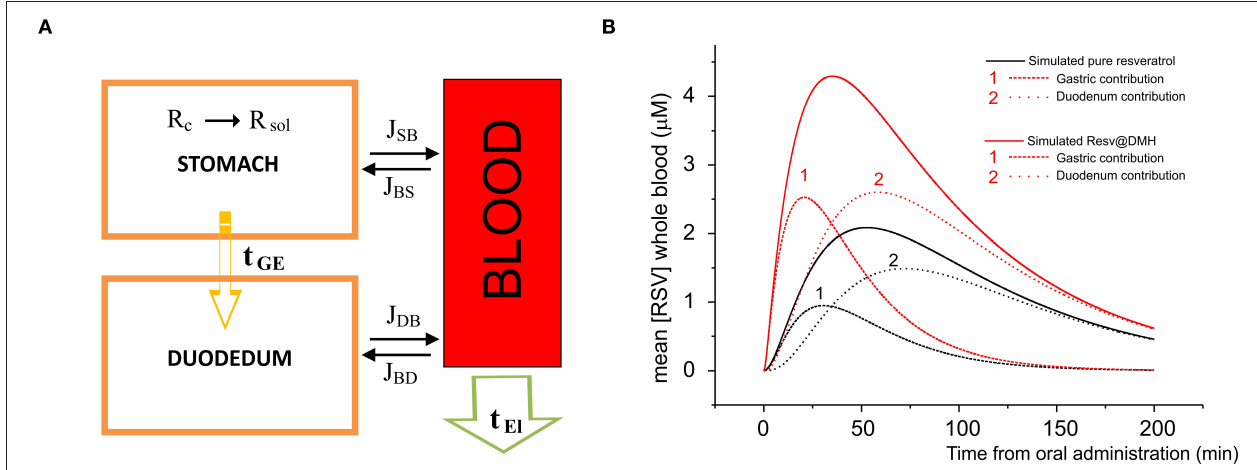
FIGURE 6 | (A) Model of the absorption and elimination of resveratrol occurring in stomach, duodenum, and blood apparatus. Dissolution of resveratrol starts in the stomach and is indicated by R (s) → R (aq); resveratrol is transported toward the duodenum according to a gastric empty time τ GE; the water solution of resveratrol is absorbed by the blood apparatus through stomach and duodenum membranes, according to the dissolution time and the gastric empty time; the passage (flux) from the stomach to the blood apparatus and vice versa, and from the duodenum to the blood apparatus and vice versa is indicated by J SB , J BS , J DS , J SD , respectively. Finally, resveratrol is eliminated or redistributed to other parts of the body, according to an elimination time τ El. (B) Concentration in µ M as a function of the time of pure resveratrol (black line) and Resv@MDH (red line) in plasma. Dots indicate the experimental data, while continuous curves denote the data obtained by our model. For both pure resveratrol and Resv@MDH, the contribution to the plasma concentration due to gastric and duodenum absorption are reported. The number indicates the gastric (1) and duodenal (2) contributions on both